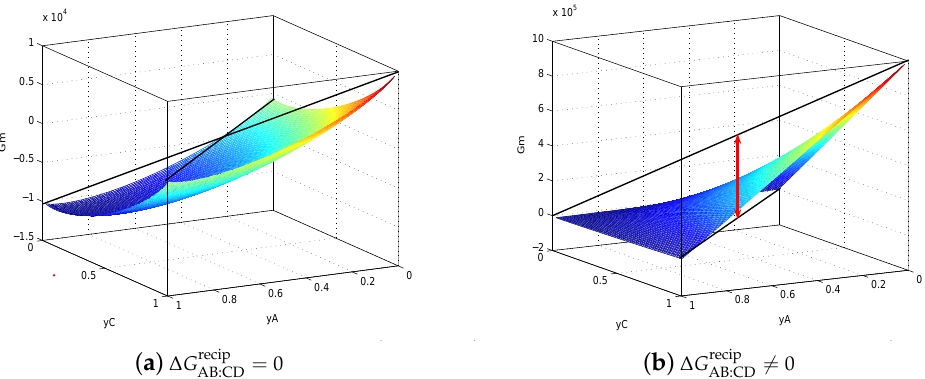
Figure 2. The Gibbs energy surface without ( a ) and with a reciprocal miscibility gap ( b